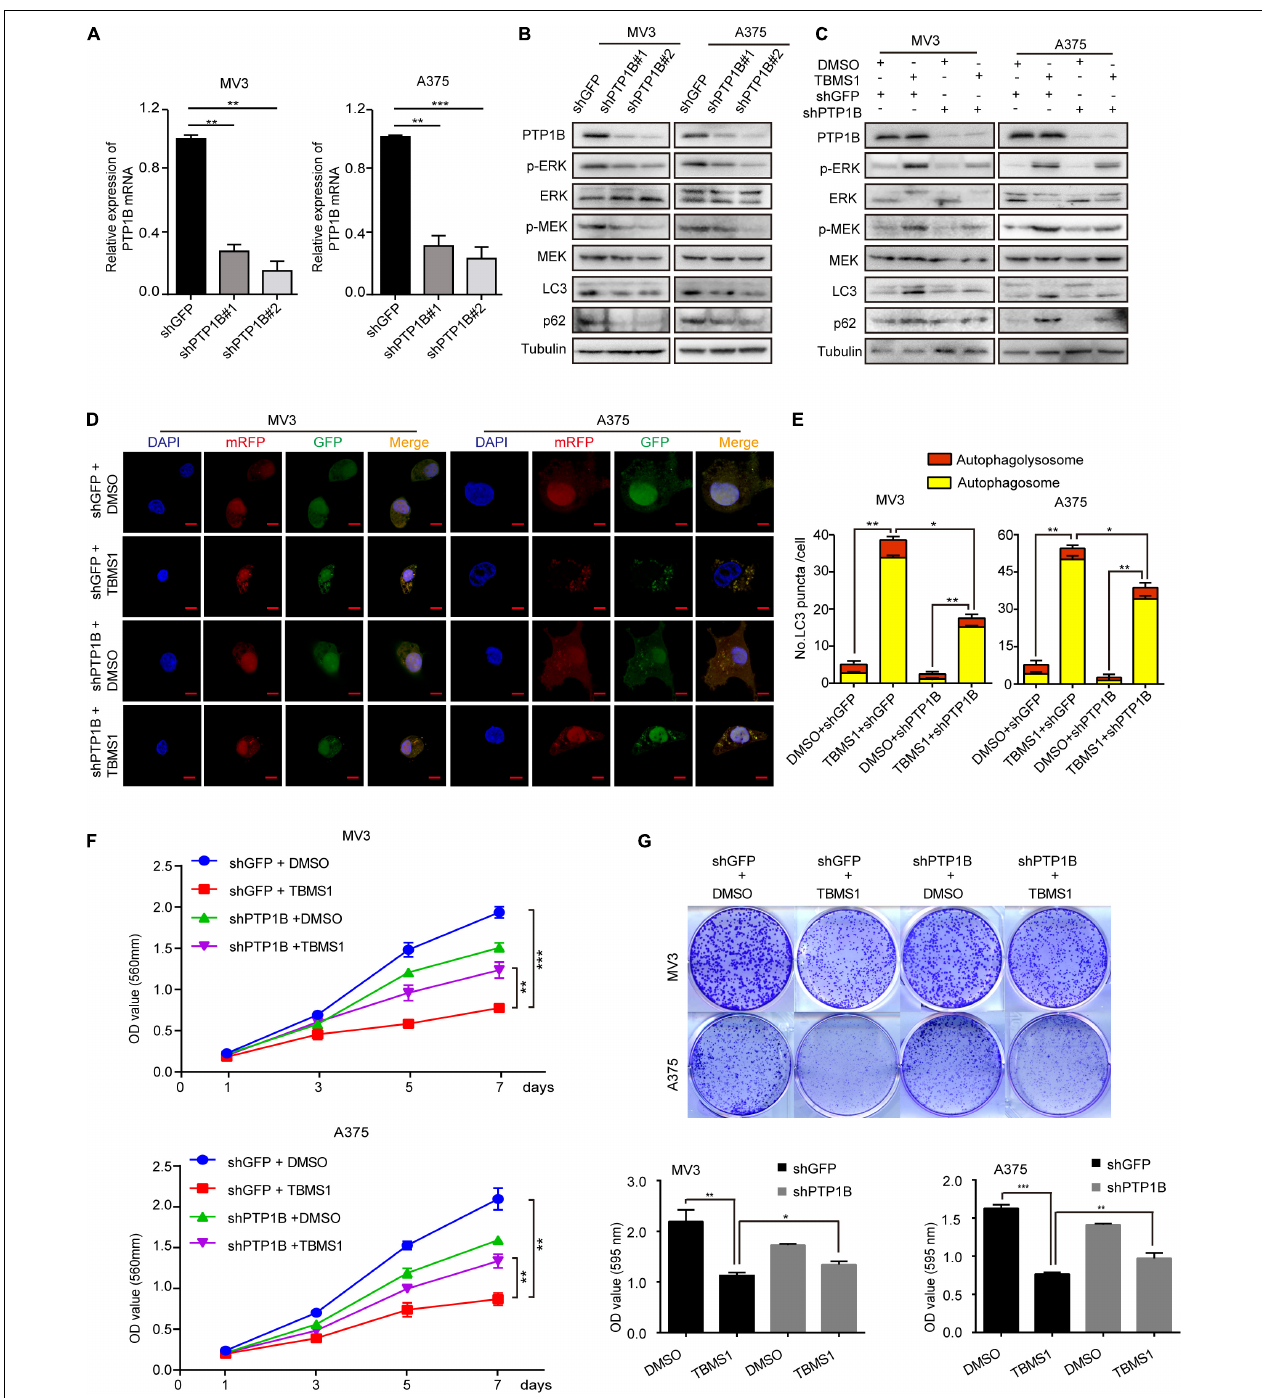
FIGURE 8 | PTP1B knockdown rescued TBMS1-induced anti-melanoma activities. (A) qRT-PCR was performed to detect the PTP1B expression in PTP1B-knockdown MV3 and A373 cells. (B) Western blot was performed to detect the PTP1B expression in PTP1B-knockdown MV3 and A373 cells. (C) Western blot results showed the expression level of p-ERK1/2, ERK1/2, p-MEK1/2, MEK1/2, LC3B, and p62 in PTP1B-knockdown melanoma cells. (D,E) After transfected with mRFP-GFP-LC3 plasmids, the level of autophagy was tested by immunofluorescence staining assay in PTP1B-silenced MV3 and A375 cellstreated with TBMS1 for 48 h. PTP1B was transfected in two target cells 24 h before TBMS1 treatment. The yellow (autophagosomes) and red signals (autophagolysosome) in every cell per slide were calculated. (F) Viability of PTP1B-knockdown MV3 and A375 cells after treated with TBMS1. DMSO was used as control. (G) Clonogenicity of PTP1B-knockdown MV3 and A373 cells treated with TBMS1. The formation of clones after 10 days culture. On the side is the quantitative figure of clonogenic assay results. A two-tailed unpaired Student’s t -test was carried out. * p < 0.05, ** p < 0.01, *** p < 0.001, **** p < 0.0001.